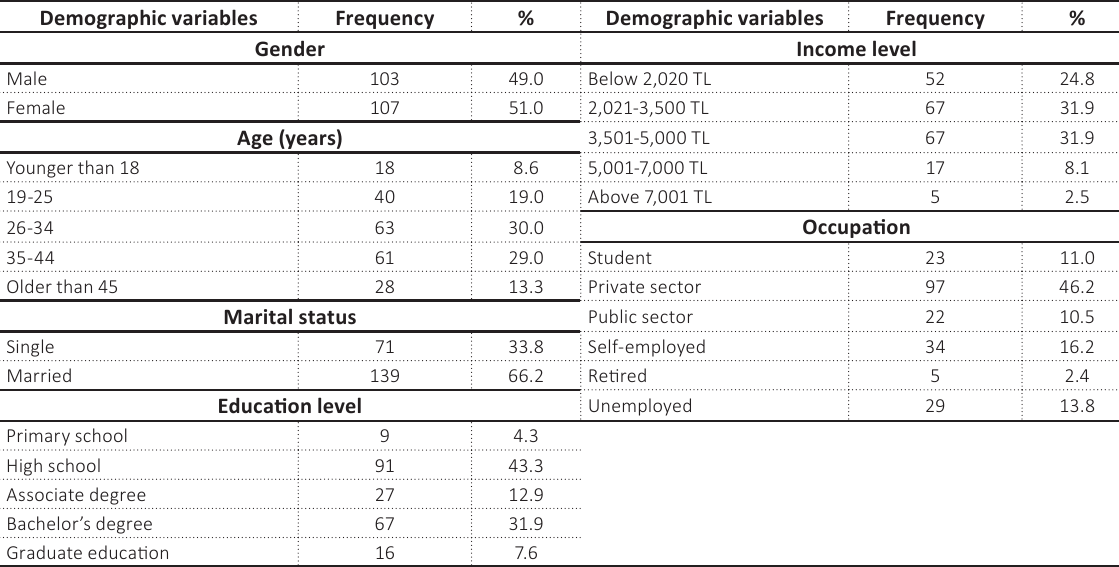
Table 1. Demographic characteristics of the sample